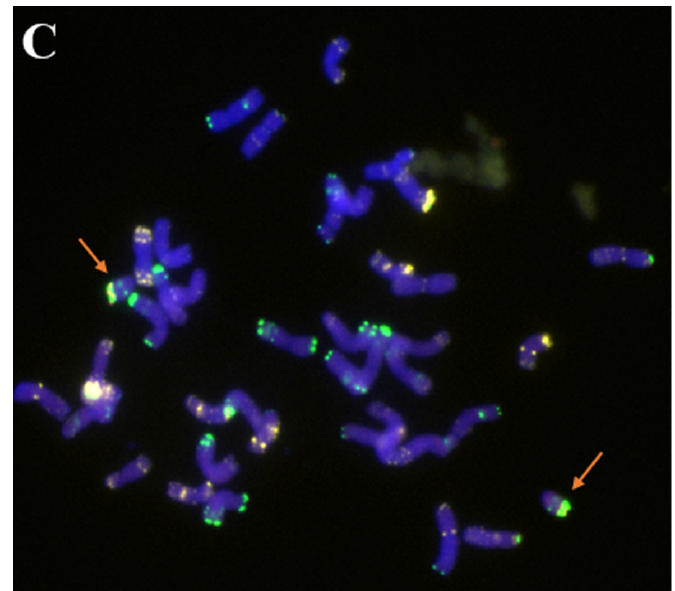
Figure 6. Cytogenetic identification (600x) in the BC 2 F 6 generation. ( A ) 6R monosomic addition plant; the arrow shows the 6R chromosome. ( B ) 6R disomic addition plant; the arrows show the 6R chromosomes. ( C ) 6RS addition plant; the arrows show the 6RS chromosome arms. Oligo-pSc119.2-1: green, Oligo-pTa535-1: white, Oligo-Ku, Oligo-pSc200, and Oligo-pSc250: red. The chromosomes were blue. Table 2. Relationship between resistance ability and chromosome types in BC 2 F 6 in the field in 2020. Chromosome Types